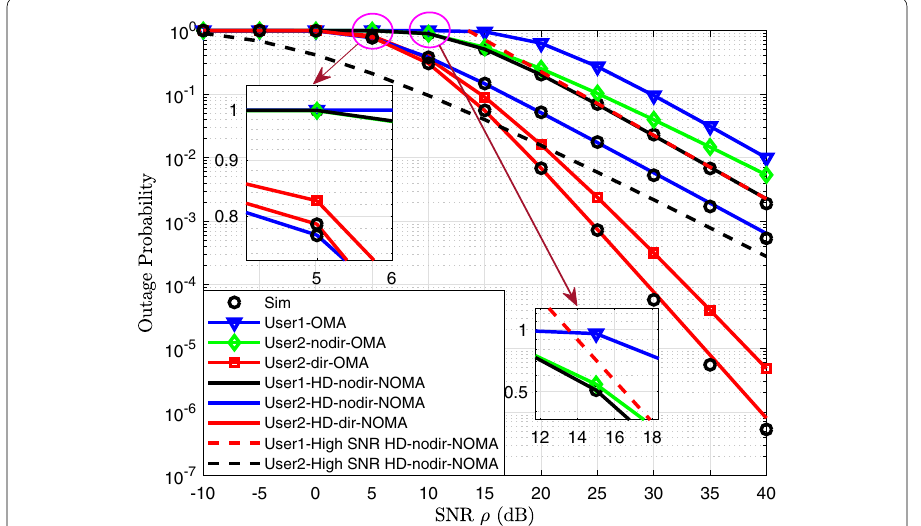
Fig. 3 Outage probability of two users versus transmitting SNR in cases of no direct link and direct